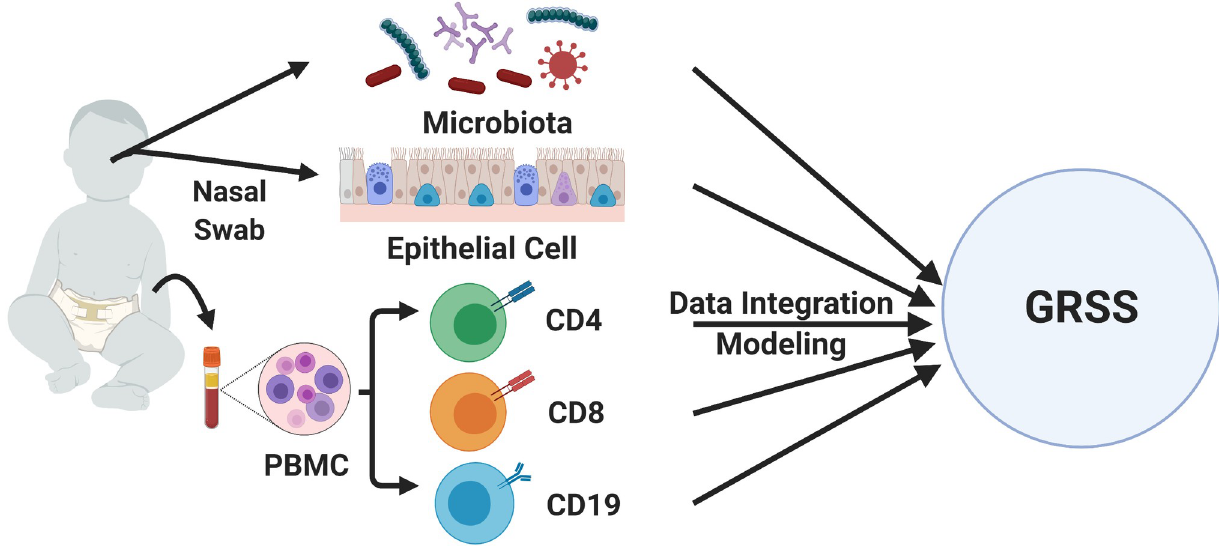
Fig 1. Overview of the study design. Measurements of the nasal epithelial cell transcriptome and nasal microbiome were generated from nasal swabs of infants. Measurements of peripheral immune cells (CD4, CD8, and CD19) were obtained from blood samples. These measurements were subsequently integrated and associated with RSV disease severity